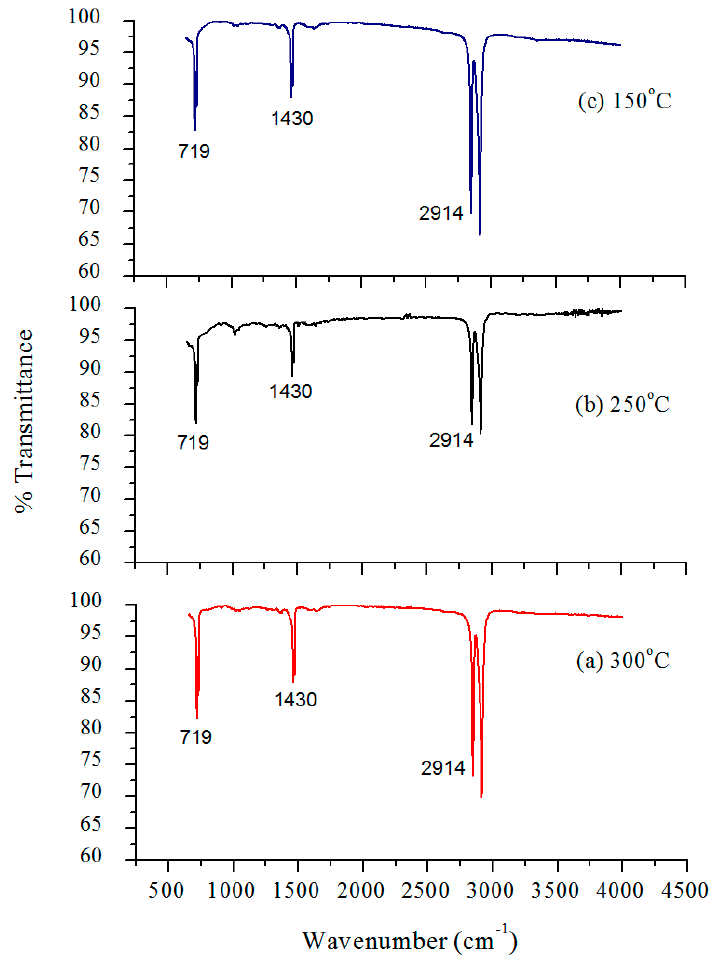
Figure 6. FTIR spectra of injection molded HDPE/TiO 2 nanocomposites at 5 wt % TiO 2 and residence time of 50 min. Barrel temperature was varied at: ( a ) 300 °C; ( b ) 250 °C; and ( c ) 150 °C.